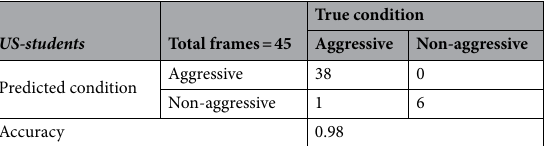
Table 2. Comparison of the predicted results and real conditions of the proposed scheme with the test fragments of US-students .